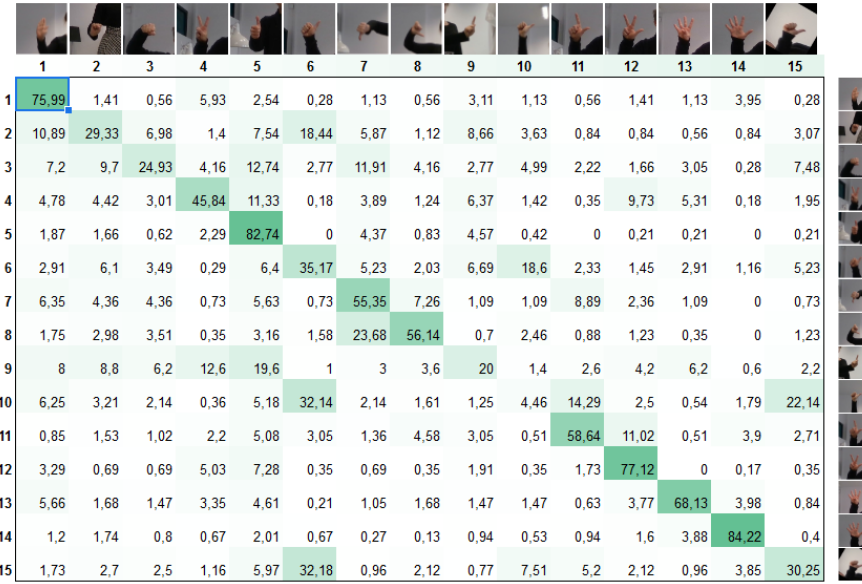
Figure 35. A 5-NN classification of gestures based on the skeleton model.